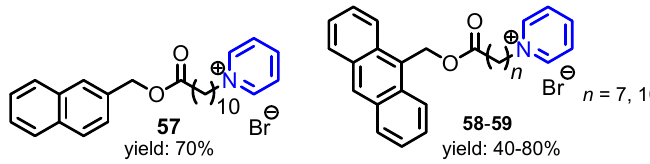
Figure 3. Structure of pyridine salts 57 − 59 [32]. Ali et al. [33] reported synthesis of eight N-alkylated pyridine-based organic salts 60 – 67 (Scheme 11) and their antibacterial and antibiofilm activities. The best antibacterial activity was shown by compound 66 at the concentration of 100 µ g mL − 1 with MIC values of 56 ± 0.5% against S. aureus and 55 ± 0.5% against E. coli ; followed by salt 65 (MIC = 55 ± 0.5% against E. coli ) and 61 (MIC = 55 ± 0.5% against E. coli ) at the same concentration. In the antibiofilm activity, salts 65 , 60 and 67 inhibited 58 ± 0.4% S. aureus at a concentration of 75 µ g mL − 1 , while 61 inhibited 55 ± 0.5% E. coli at concentration of 100 µ g mL − 1 .